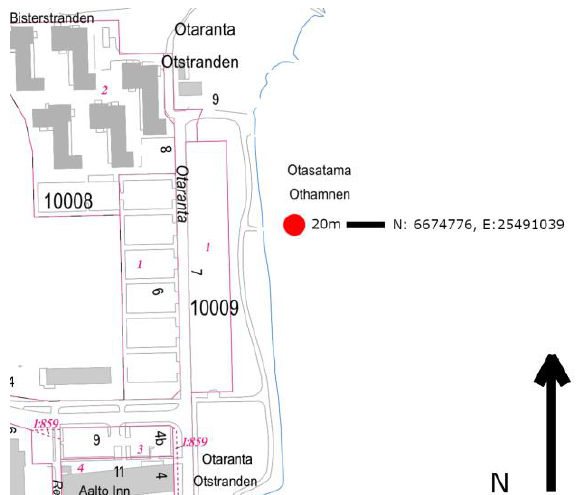
Figure 1. The measurement location in Otaranta.(Espoon karttapalvelu, 2020) (Map set © Kaupunkimittausyksikkö,